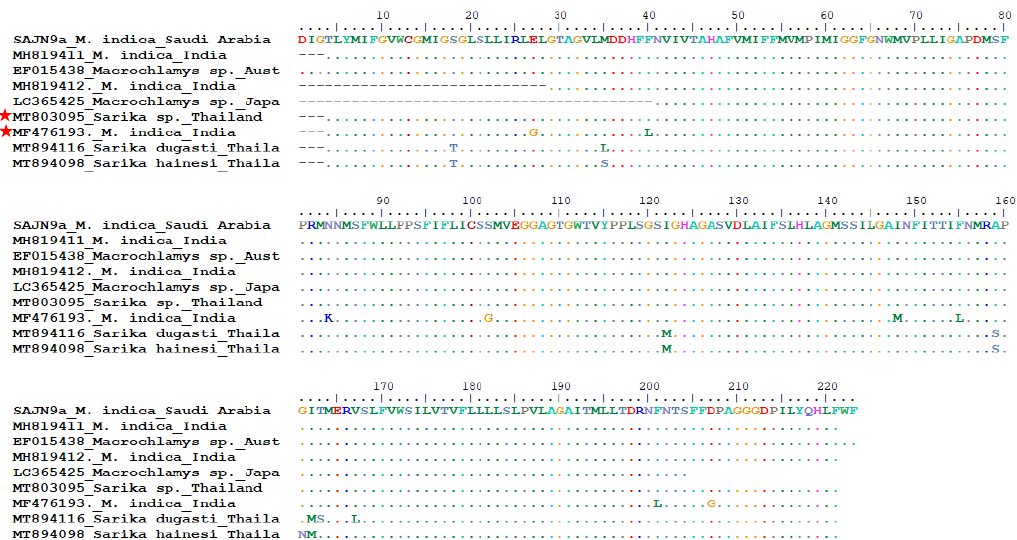
Figure 6. An alignment of amino acid sequences deduced from COI DNA sequences of different snail specimens collected from Saudi Arabia (SAJN9a, M. indica ) and other closely related homologous sequences retrieved from the NCBI-GenBank database. Dashes refer to missing positions and dots indicate that amino acid residues are identical at these positions. The one star indicates that the COI sequence of MT803095 accession number is misidentified and the two stars indicates that the COI sequence of MF476193 accession number has many artifact DNA nucleotides as all of them are “Gs” and they produce different amino acids compared with their closely related taxa.